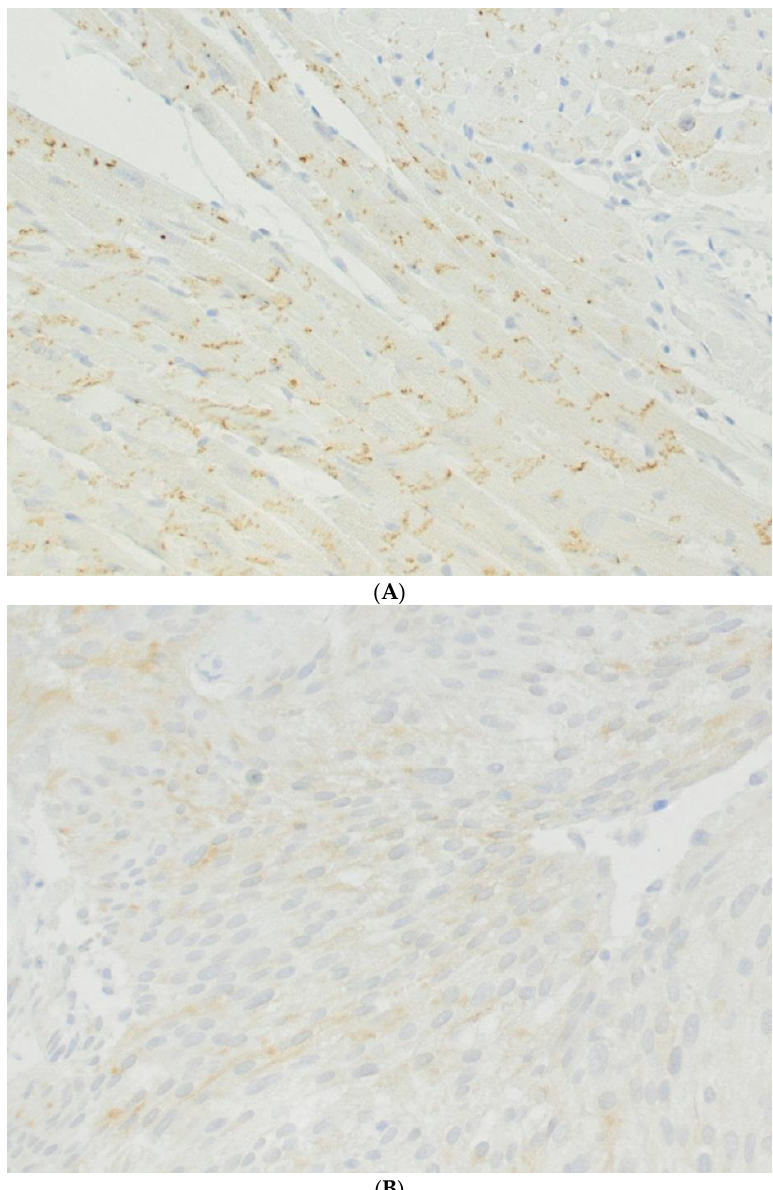
Figure 3. Representative microphotographs show the specific labeling of connexin 43 in the heart ( A ). The intercalated disks which express connexin 43 are labeled with a brown dye. A weaker but clear expression of connexin 43 can be observed on a section of a human urinary bladder cancer ( B ).